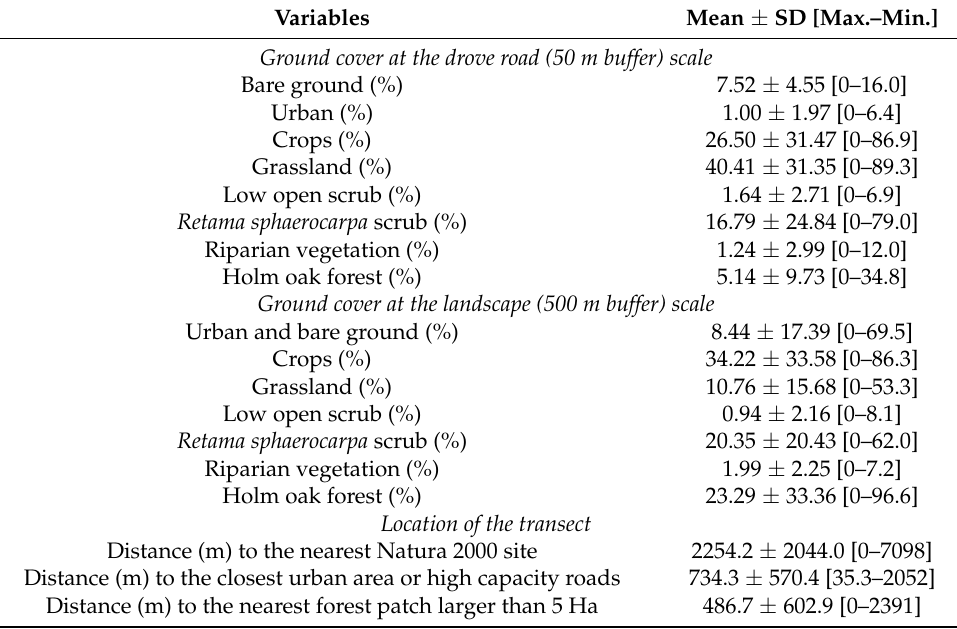
Table 1. Variables tested in explicative models of bird richness and abundance in transects carried out in drove roads. Variables are organized in the three potential explanatory sets used for initial models, and descriptive values for sampled transects included for informative purposes. Mean ± SD